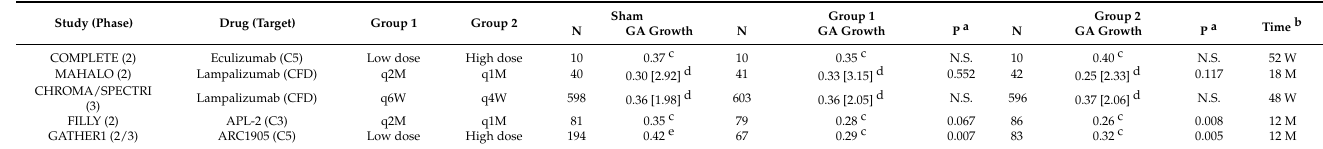
Table 1. Published Phase 2 and 3 clinical trials evaluating complement inhibition to slow geographic atrophy (GA).